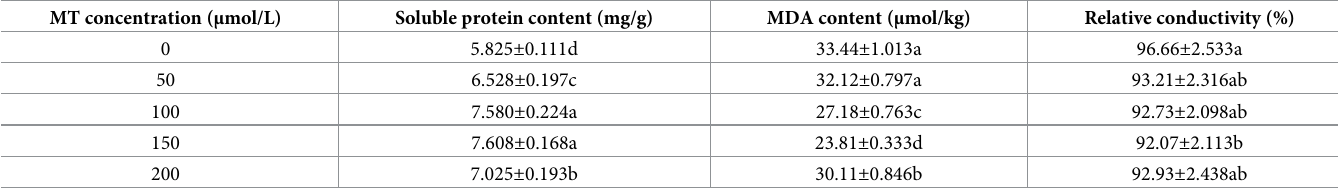
Values are means ( ± SE) of three replicate pots. Different lowercase letters within a column indicate significant differences based on one-way analysis of variance in SPSS 22.0 followed by the least significant differences ( p � 0.05). MDA =